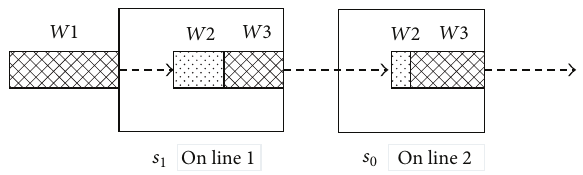
Figure 2: Example of compositions of waiting